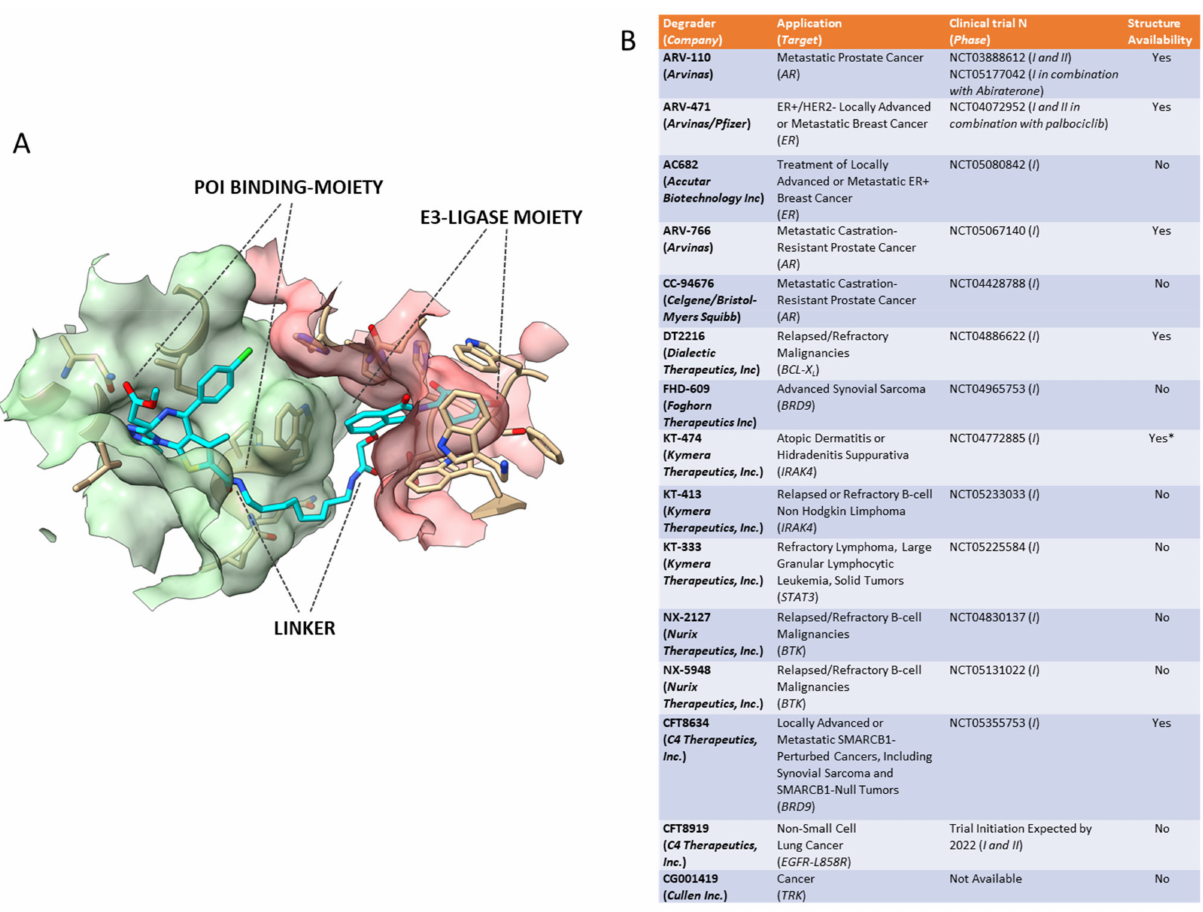
Figure 1. ( A ) Prototypical structure of a Proteolysis Targeting Chimeric Molecules (PROTAC) based on the example of dBET23 PROTAC (Protein Data Bank number 6BN7). PROTACs favor the formation of a ternary complex involving the PROTAC itself (cyan structure), a protein of interest (POI) in the case of the DNA damage-binding protein 1 (green surface), and a cell E3 ligase in the case of the Protein cereblon (pink surface). This is made available by the coexistence, in the same molecule, of a POI-binding moiety and an E3 ligase-binding moiety (in the case of thalidomide) joined by a linker of suitable length. ( B ) A list of PROTACS involved in clinical trials. Abbreviations: AR—androgen receptor; ER—oestrogen receptor; BCL-xL—B cell lymphoma- extra-large; BRD9— bromodomain-containing protein 9; BTK—Bruton’s tyrosine kinase; EGFR-L585R—epidermal growth factor receptor harboring the exon point mutation L858R; ER—oestrogen receptor; HS—hidradenitis suppurativa; IND-e—IND- enabling preclinical studies; IRAK4—interleukin-1 receptor-associated kinase 4; STAT3—signal transducer and activator of transcription 3; TRK—tropomyosin receptor kinase. * Ingo Hartung su Twitter: “The plot thickens regarding the structure of IRAK4 PROTAC KT-474 @KymeraTx. 2 patents disclosing deuterated, crystalline & salt forms of a single PROTAC. Comprising a non-conventional CRBN binder the chemists at Kymera seem to like a lot. More common NH-linked IMiD in KT-413? https://t.co/O8JMRLZvpY\T1\textquotedblright/Twitter (accessed on 1 March